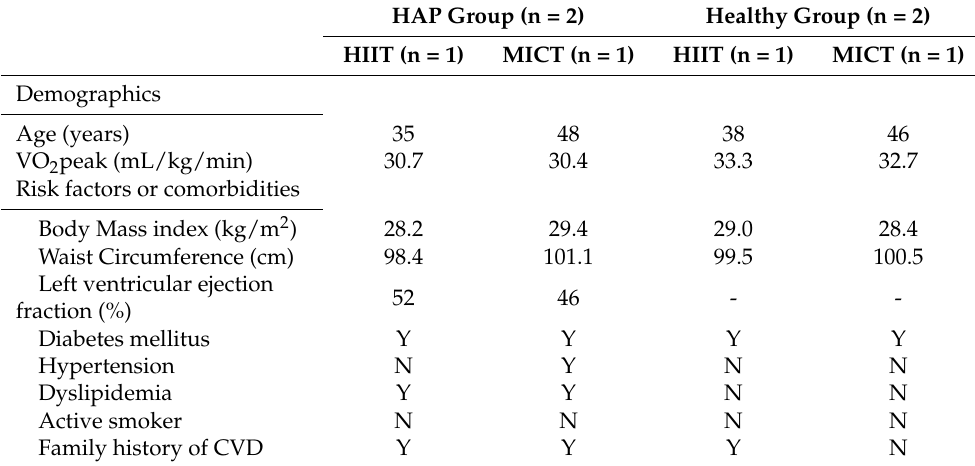
Table 1. Participant